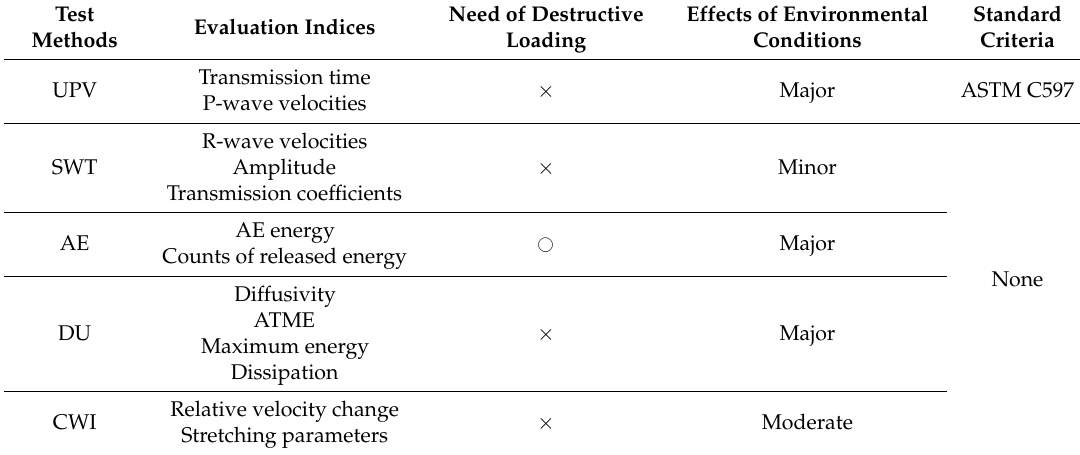
Table 4. Considerations for application of ultrasonic methods on in-situ structures for self-healing evaluation.